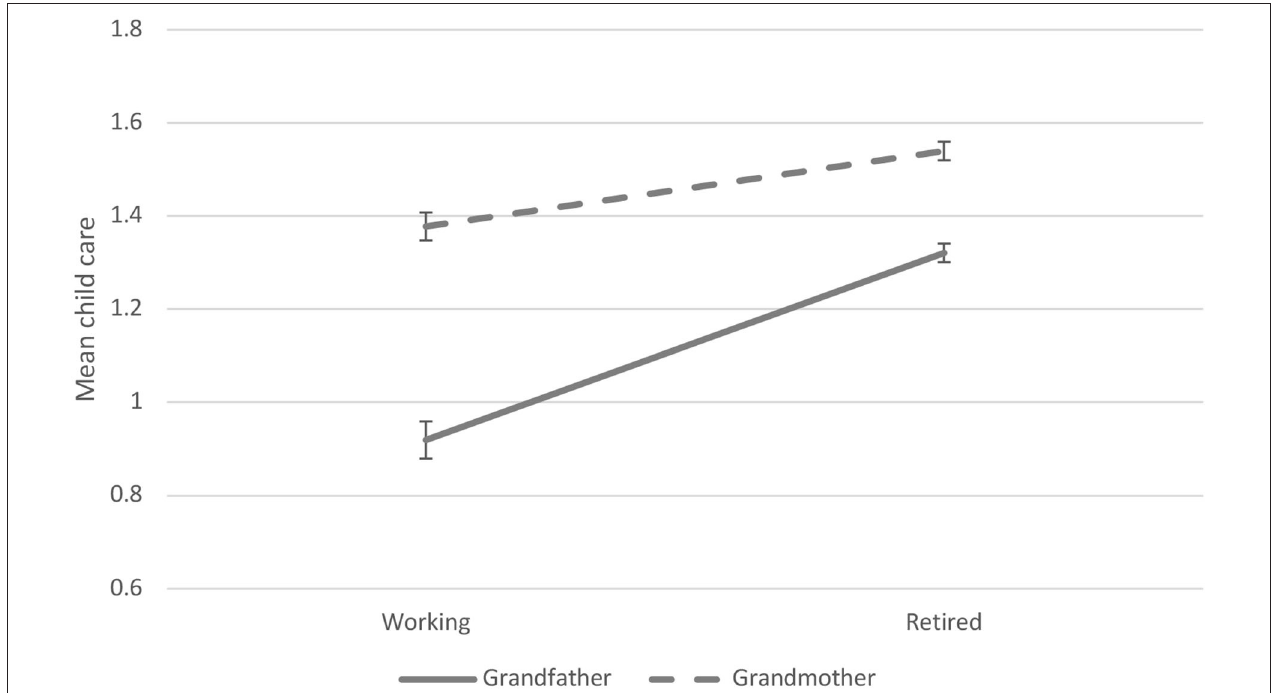
FIGURE 1 | Within-person associations between grandchild care and retirement by sex of grandparent (predictive margins and 95% CIs).